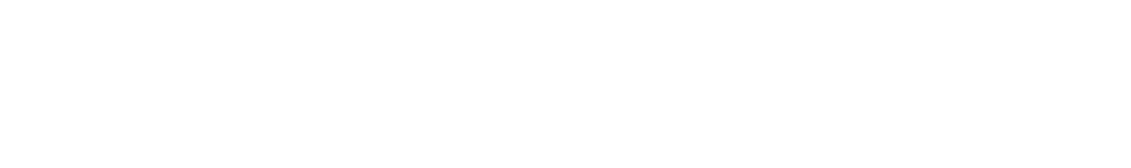
Frontiers in Molecular Biosciences |